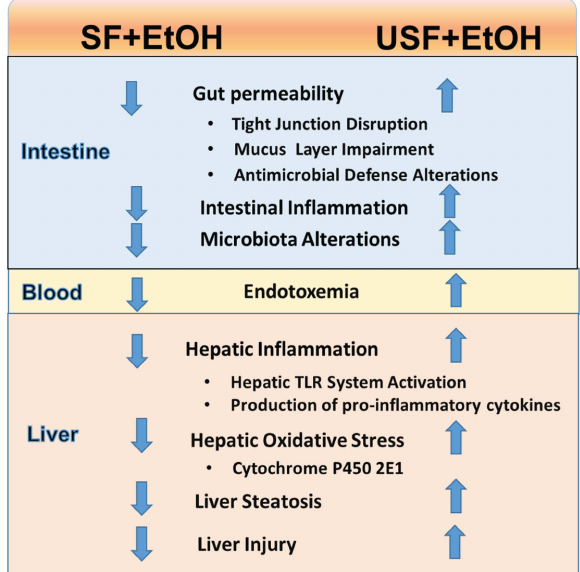
Figure 4. Differential effects of dietary saturated and unsaturated fat on EtOH-induced intestinal and liver